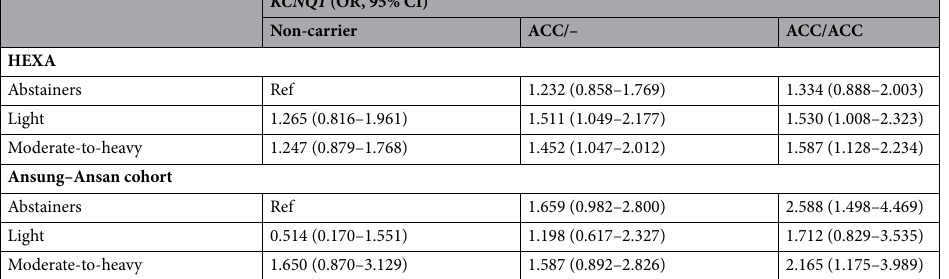
Table 3. Association between type 2 diabetes and the KCNQ1 haplotype according to alcohol consumption in the HEXA and Ansung–Ansan cohorts. The p -values were calculated by multivariate logistic regression models adjusted for age, sex, smoking, body mass index, family history of diabetes, physical activity, and income level.